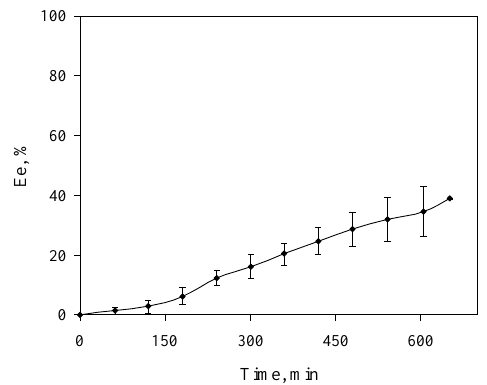
Figure 1. Temporal variation of extraction efficacy. Aqueous solution: 100 µg·L −1 Ni 2+ , pH = 8, 35 g·L −1 NaCl. Receiving solution: 1.3 mol·L −1 HCl. Organic solution: 0.89 mmol·L −1 1,2-CHBBH. Stirring rate: 500 rpm .